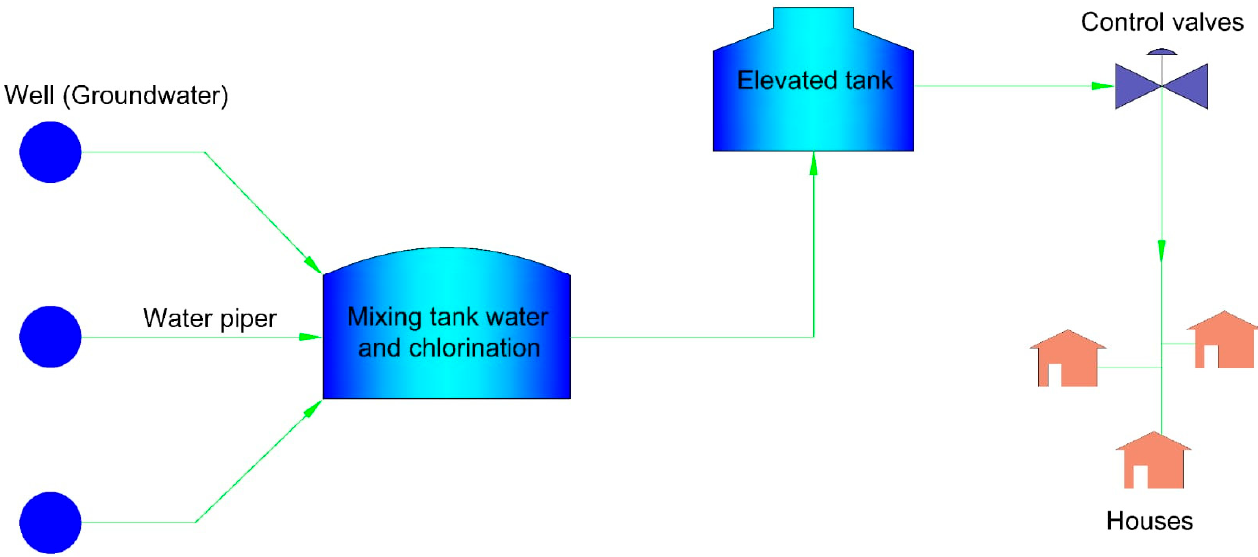
Figure 4. Distribution system and water chlorination treatment.